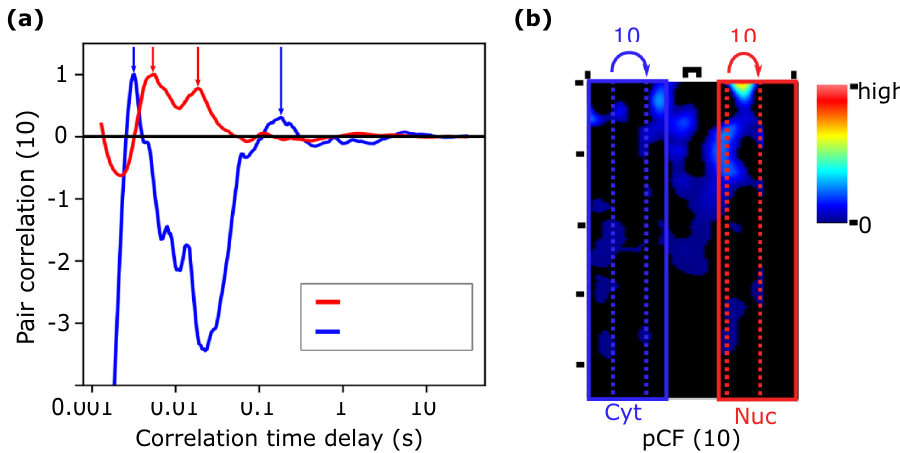
Figure 3. pCF analysis of cytoplasm-to-cytoplasm (blue) and nucleus-to-nucleus (red) C-DENV mobility shows two peaks in the pCF function suggesting the presence of two protein populations with different mobilities. ( A ) Averaged normalized pCF(10) curves show that C protein moves faster in the cytoplasm ( t short cyto = 3 ms , corresponding to an apparent diffusion coefficient of approx. 40 μm 2 /s) than in the nuclear compartment ( t short nucleus = 6 ms , corresponding to an apparent diffusion coefficient of approx. 20 μm 2 /s). Interestingly, both compartments show two positive peaks in the pCF function (two correlation time delays), suggesting the presence of two protein populations with different mobilities. Peaks in the pCF with negative values were not included in the analysis as they correspond to anti (minimum) or non (maximum) signal correlations. ( B ) pCF(10) kymogram. Warmer colors indicate higher pCF amplitudes. Superimposed a schematic representation of the intra-compartment pCF analysis where cytoplasmic and nuclear zones are indicated by blue and red rectangles